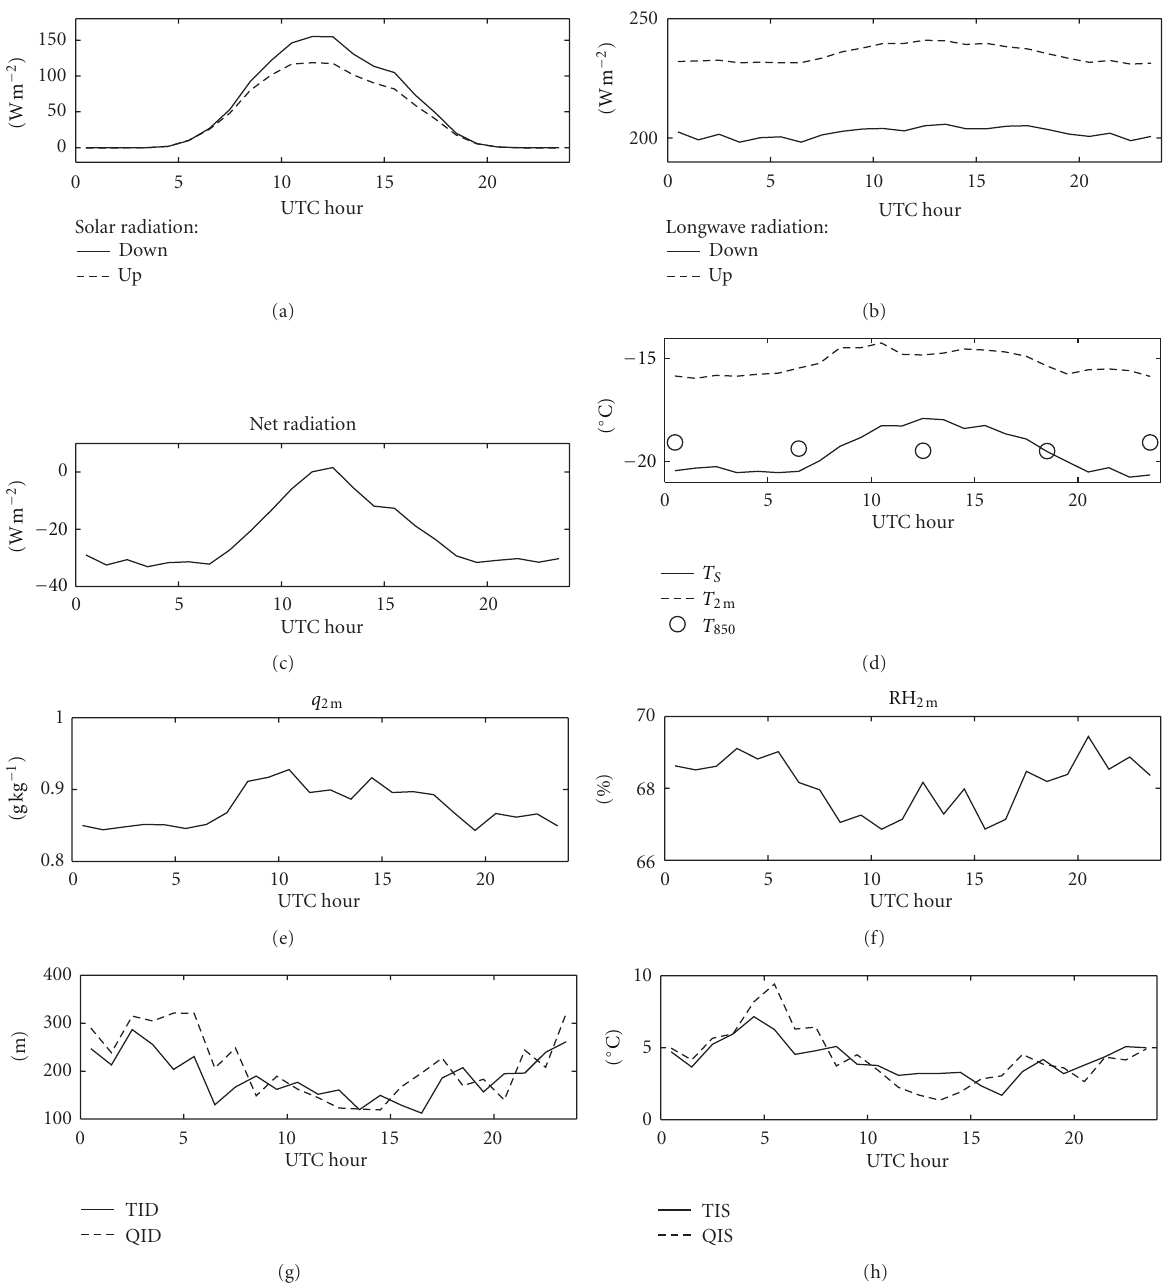
to a katabatic flow from Plat˚aberget. The near-surface air temperatures observed at the sounding site characterized the temperature of the katabatic flow at the coast. The fjord was ice-free with a constant surface temperature of about − 1.8 ◦